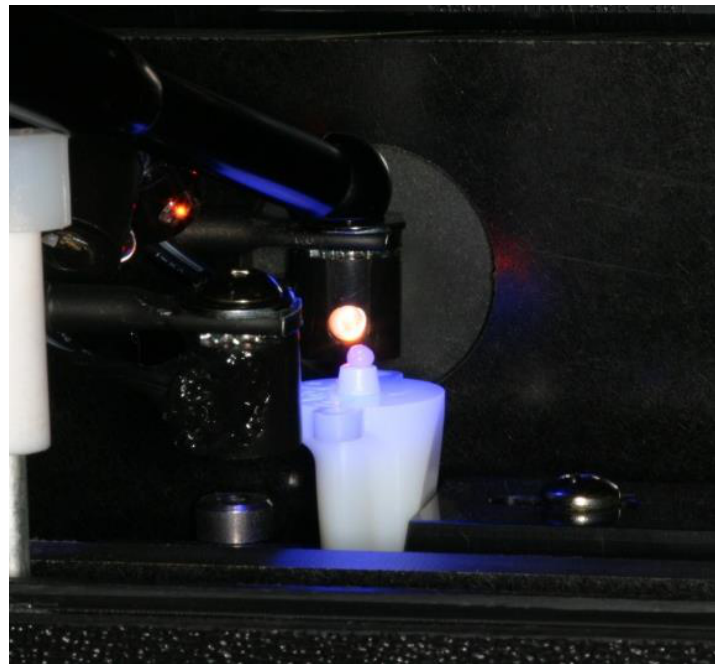
Figure 3. Light-curing of the specimen in position.